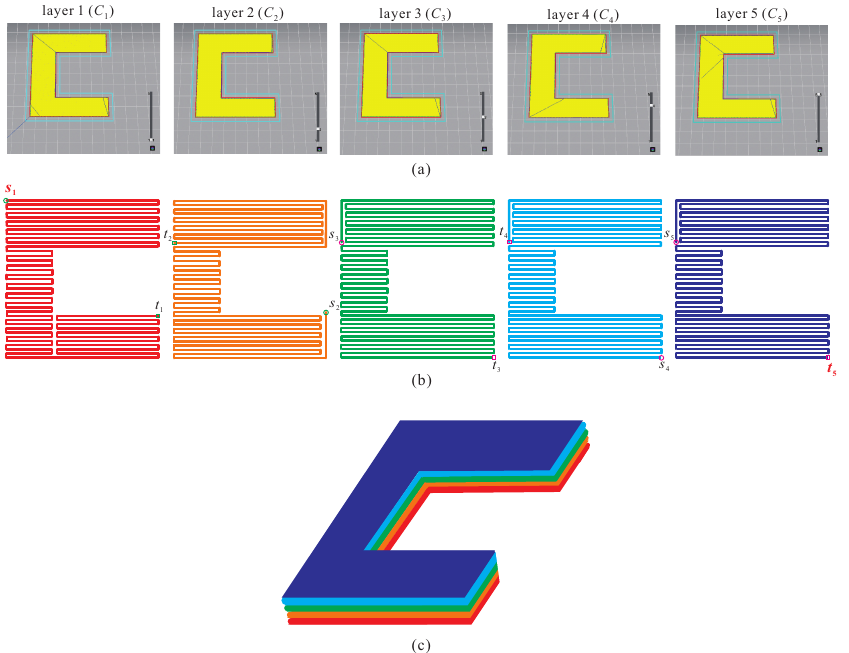
Figure 1. ( a ) The five layers C 1 – C 5 of a 3D printing model while printing a C -type object, ( b ) the computing Hamiltonian path from s i to t i of each layer C i in ( a ), and ( c ) the final result while performing the five-layered 3D